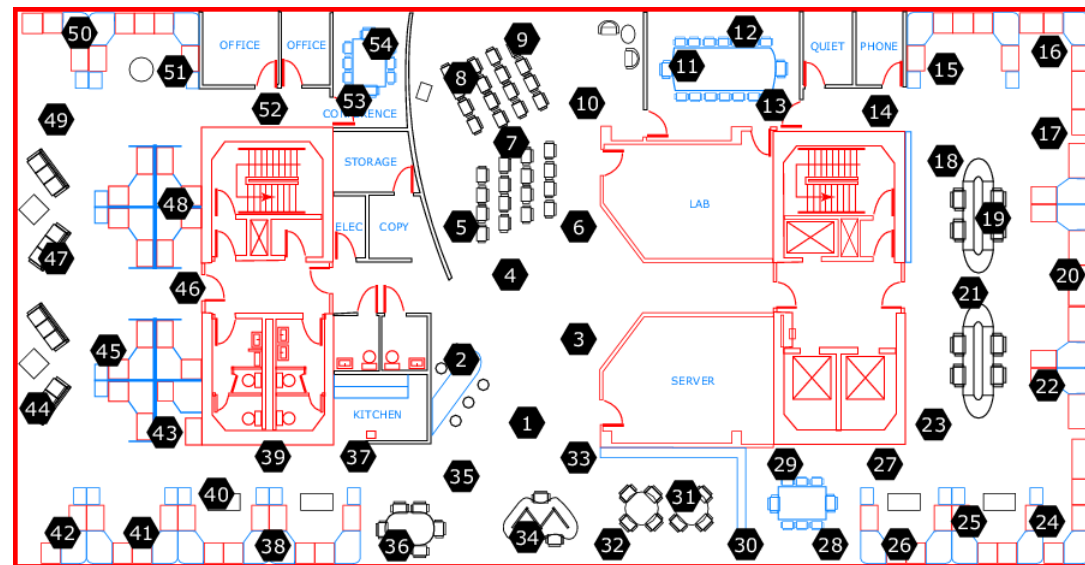
Figure 5. The topology structure of deployed